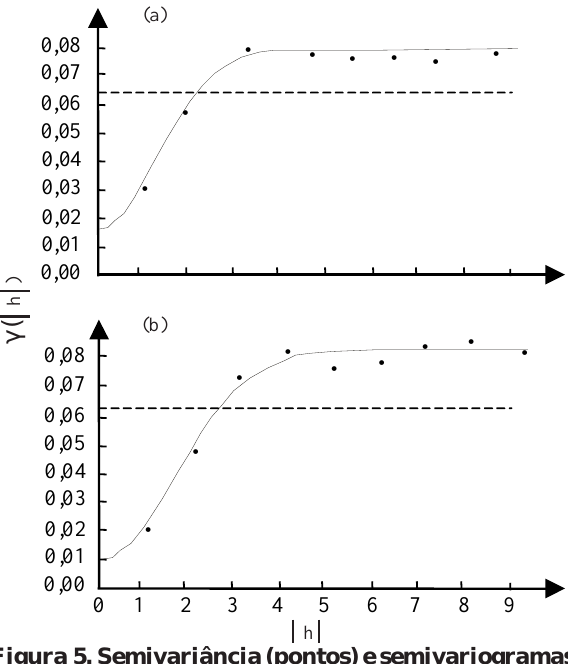
Figura 5. Semivariância (pontos) e semivariogramas modelados (linha contínua) para os resíduos do ajuste linear para o logaritmo da taxa de infiltração após 3,5 min (a) e 105 min (b). A linha interrupta representa a variância dos